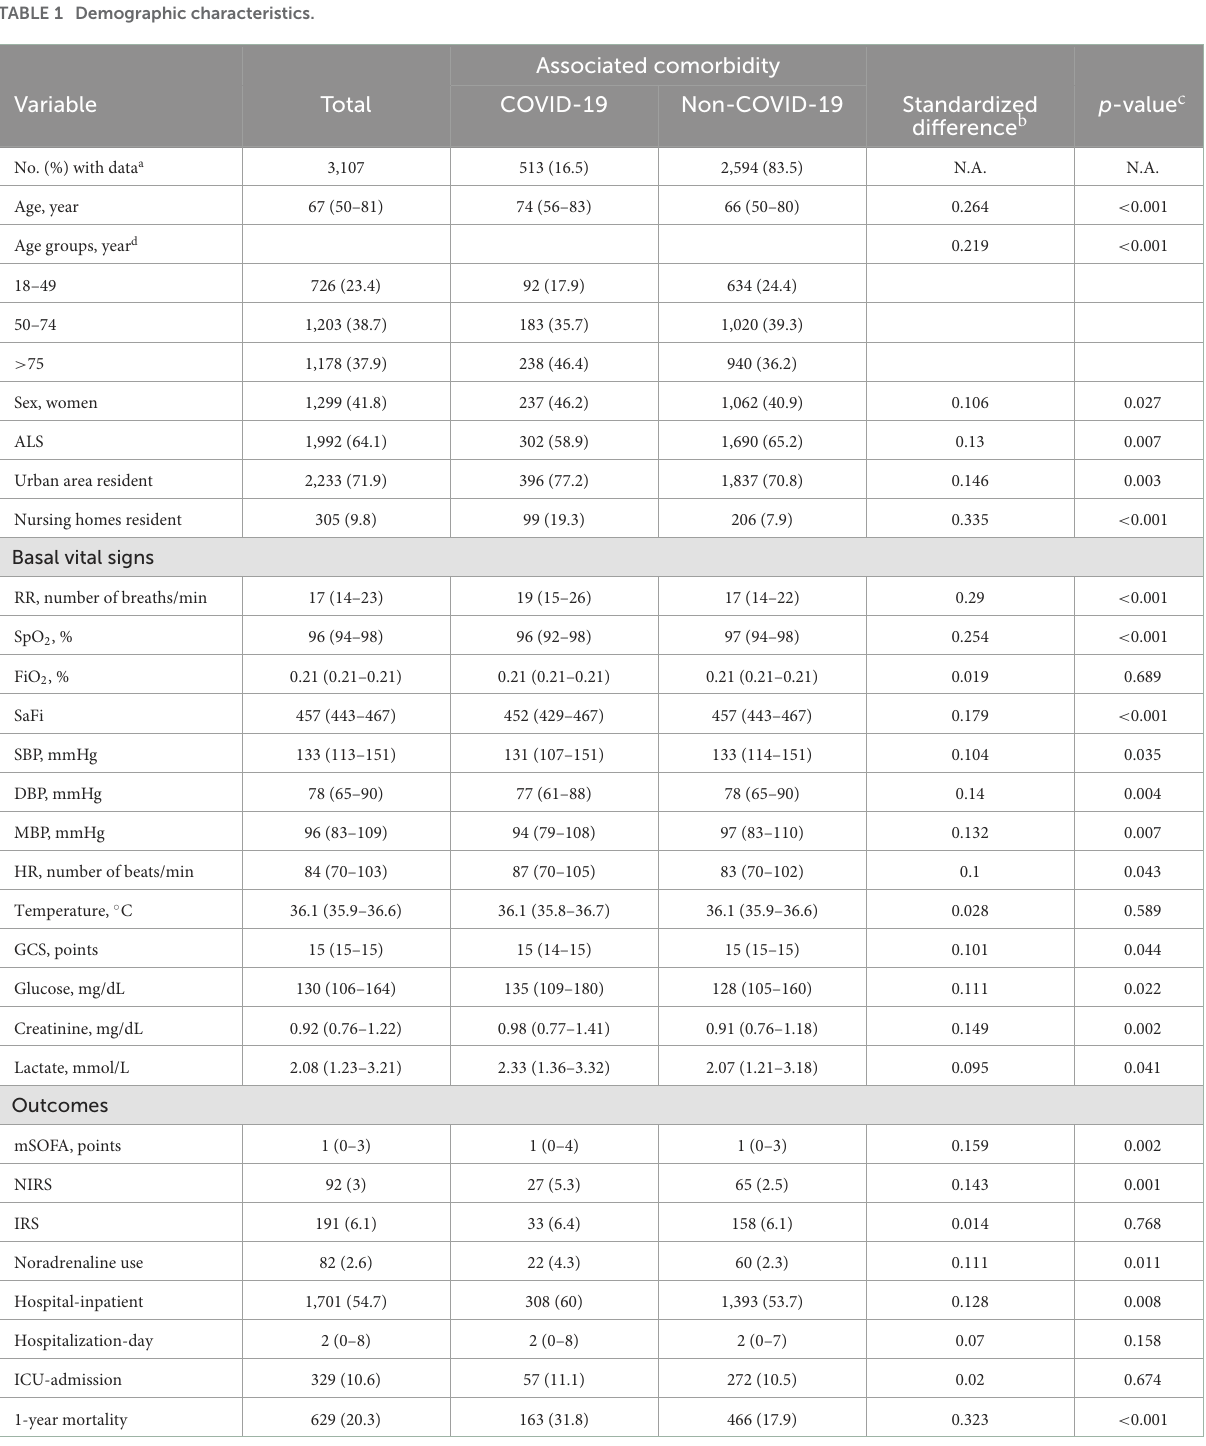
TABLE 1 Demographic